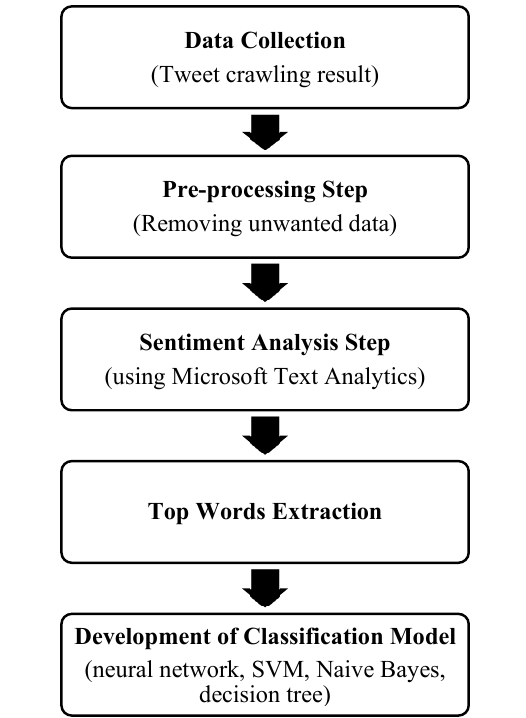
Fig. 1. Overall stages in this